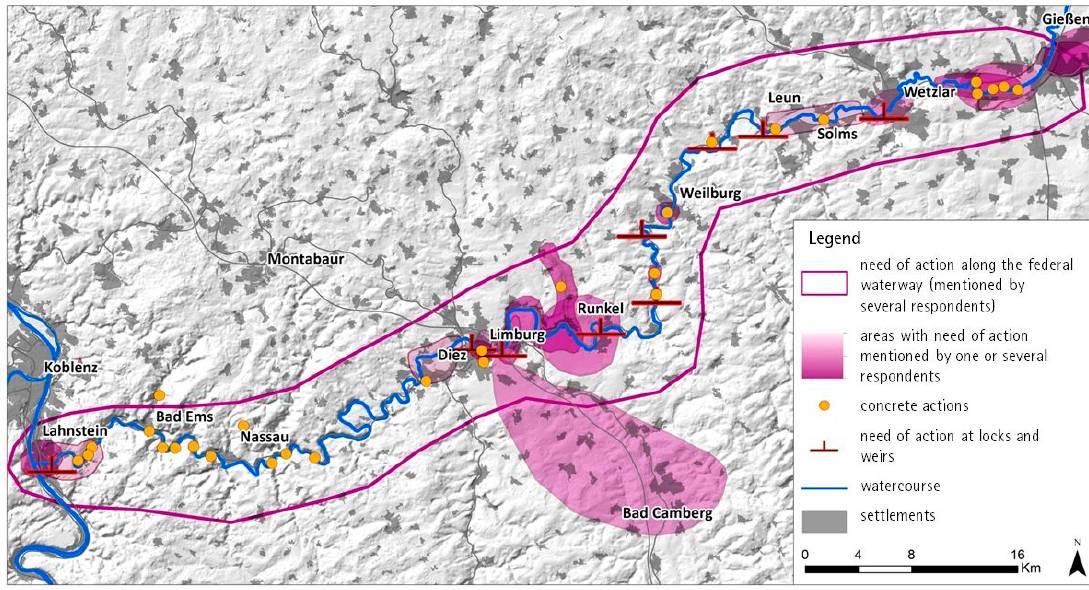
Figure 4. Areas in prioritized need of action in the case study region, illustrated by the stakeholders during the individual interviews.